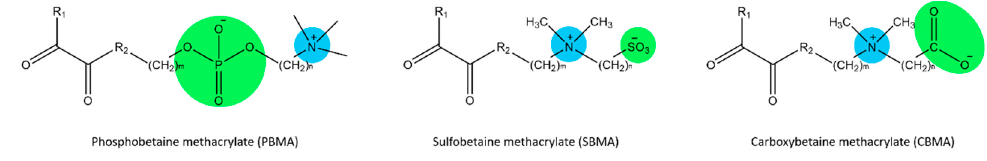
Figure 1. The chemical structures of antifouling zwitterionic material, PBMA, SBMA, and CBMA